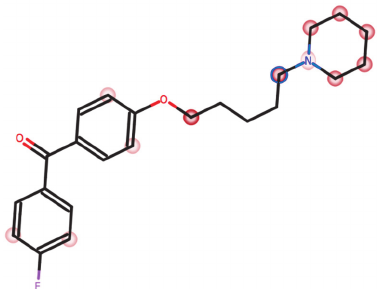
Figure 12. The MetaSite prediction of the most probable sites of metabolism for compound 6 . The sites with the highest probability of metabolic bioconversions are marked with blue circles while red marked circles indicate other potential sites of transformation (the darker the color, the higher the probability of metabolic degradation). Table 2. Metabolic stability summary: the molecular masses and metabolic pathways of 6 after in ‐ cubation with mouse liver microsomes (MLMs). Main metabolic pathways are marked in red.